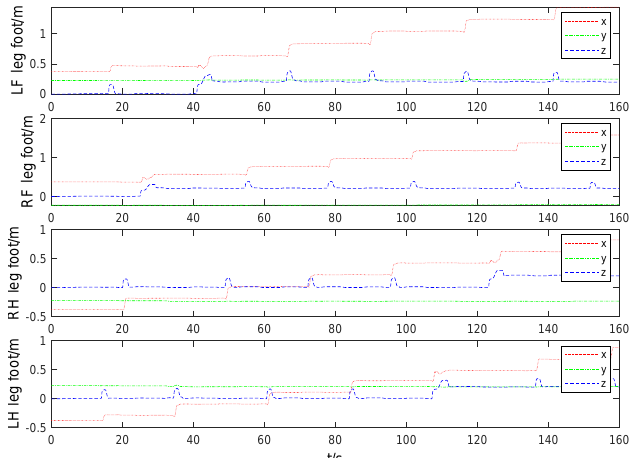
Figure 17. Comparison of four foot end-effector trajectories of quadruped robot walking on a high